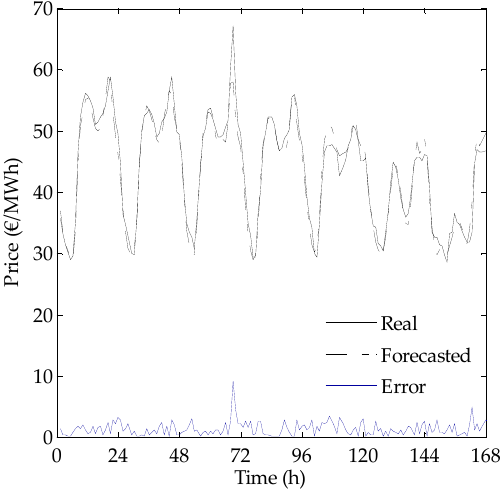
Figure 5. Winter week 2002 results for the Spanish market.